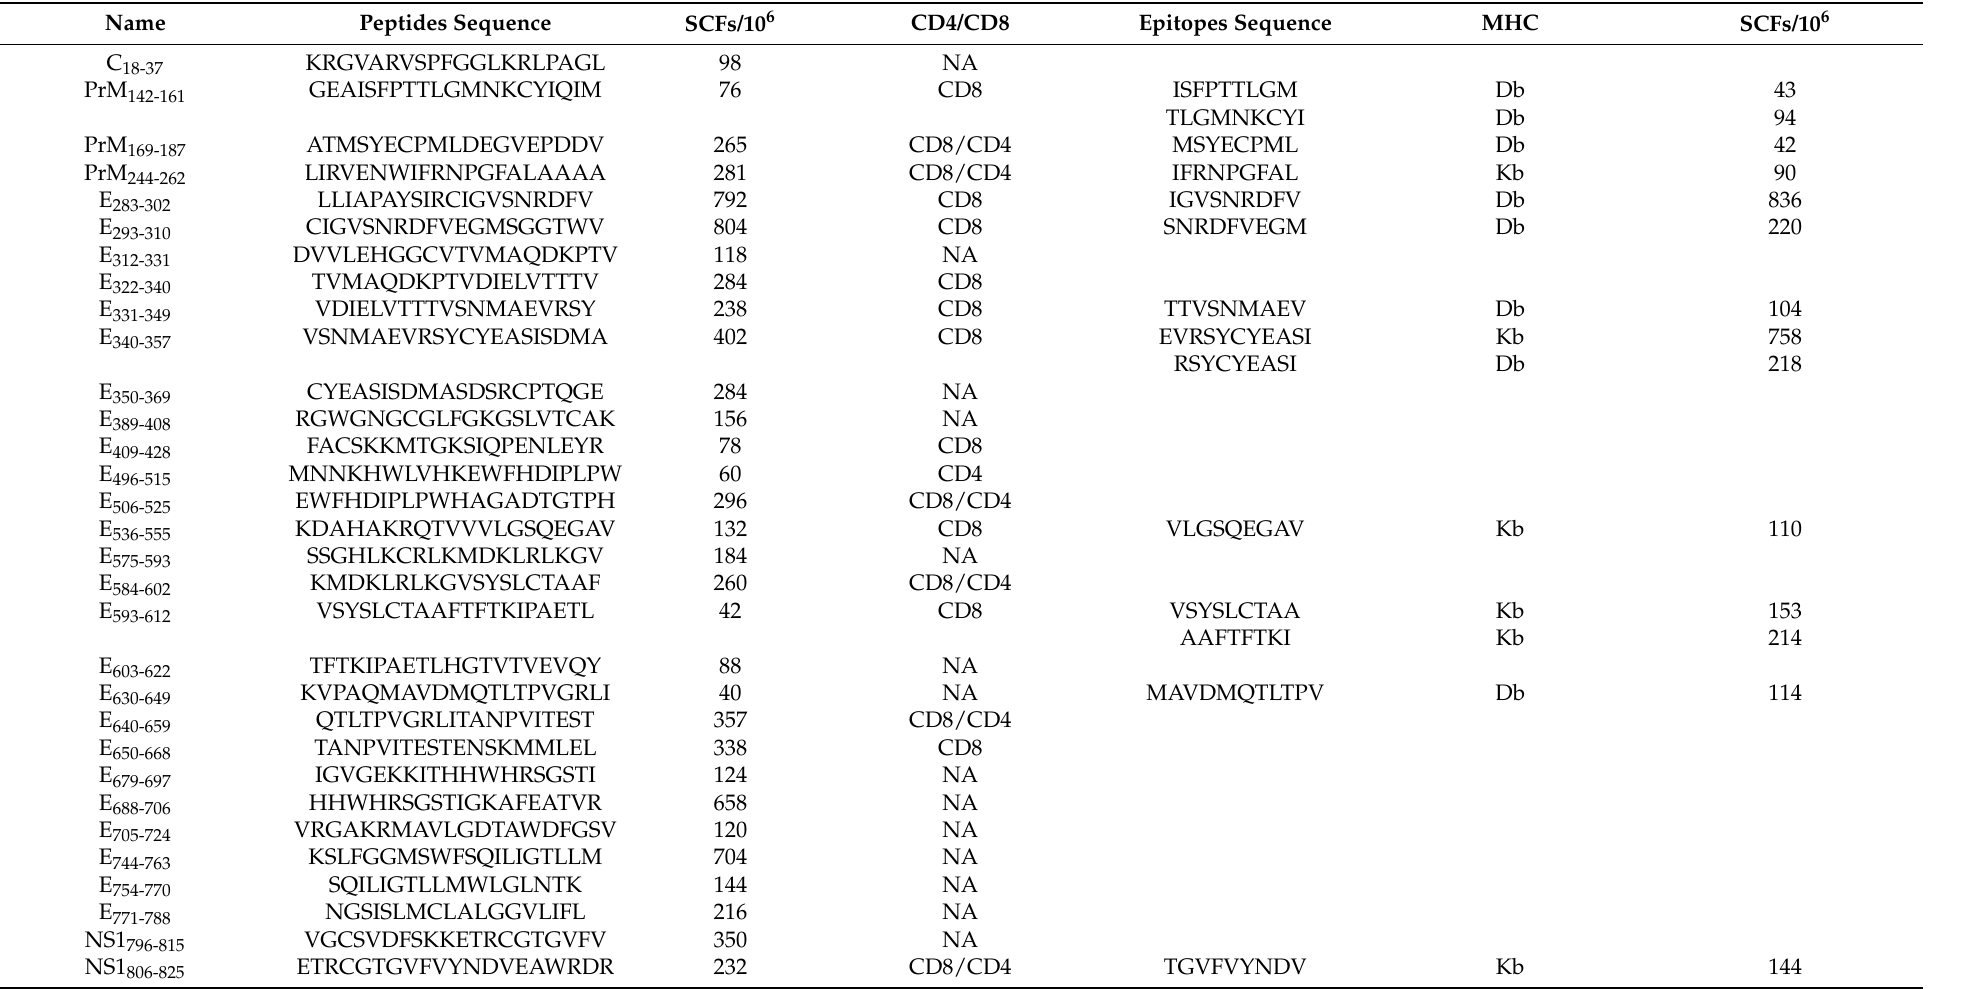
Table 1. H-2 b peptides of